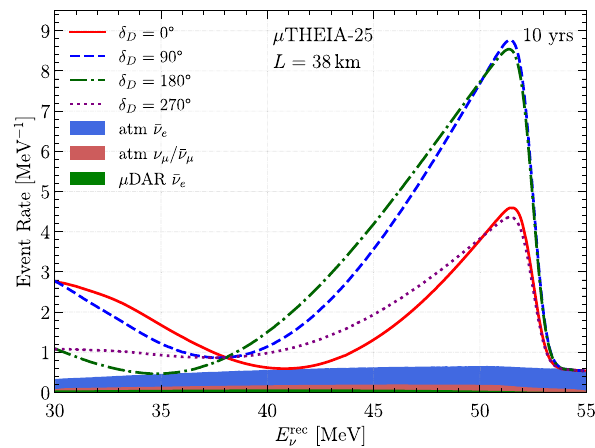
Fig. 6 The major background spectrum to the μ DAR IBD signal as a function of the reconstructed neutrino energy E rec ν at THEIA-25 (17kt) with 10 years running and a baseline of L = 38km. The remaining backgrounds are atmospheric ¯ ν e (blue), invisible muon (red), and the μ DAR ¯ ν e (green)